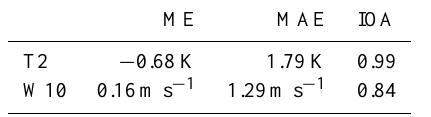
Table 4. Domain-wide error statistics for 2m temperature (T2) and 10m wind speed (W10) over Poland for 2010. ME MAE